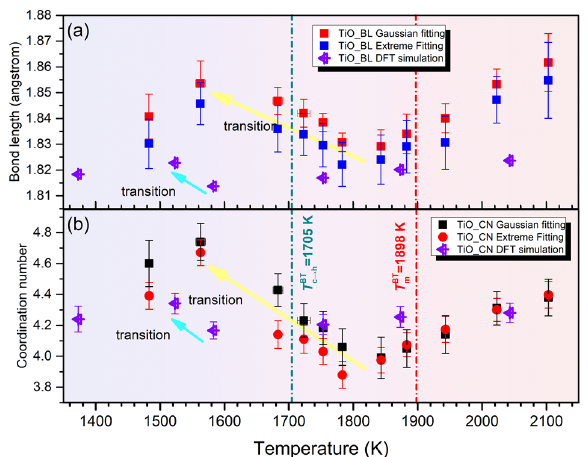
Fig. 7 Comparison of the anomalously structural transition revealed by diffraction experiment and AIMD simulation. a The bond length of Ti – O pairs and b the coordination number of Ti – O polyhedra. Two peak fi tting methods was used to deal with the fi rst Ti – O peaks in experimental T ( r ) patterns, and the extracted structural parameters are compared in this fi gure. De fi nition of error bars is the same as described in captions of Figs. 4b, c and 6a.